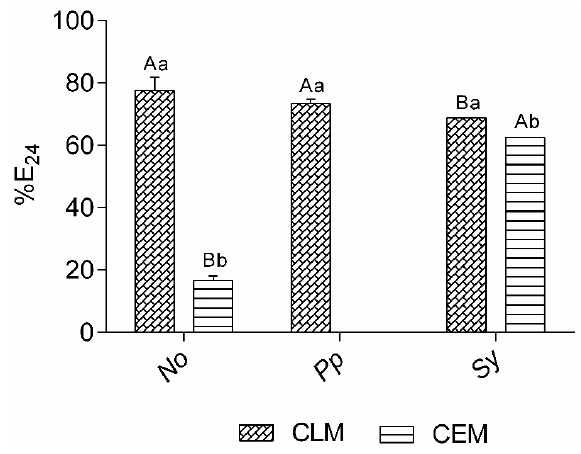
Figure 5. Emulsification index E 24 (%). CLM: clean extracellular medium. CEM: crude extracellular medium. No: Nostoc sp.; Pp: Porphyridium purpureum ; Sy: Synechocystis sp. Data are shown as mean ± SE (n = 3). Means with di ff erent letters are significantly di ff erent according to ANOVA and the Tukey test ( p < 0.05). Capital letters are for comparisons between strains, and small letters are for comparisons between